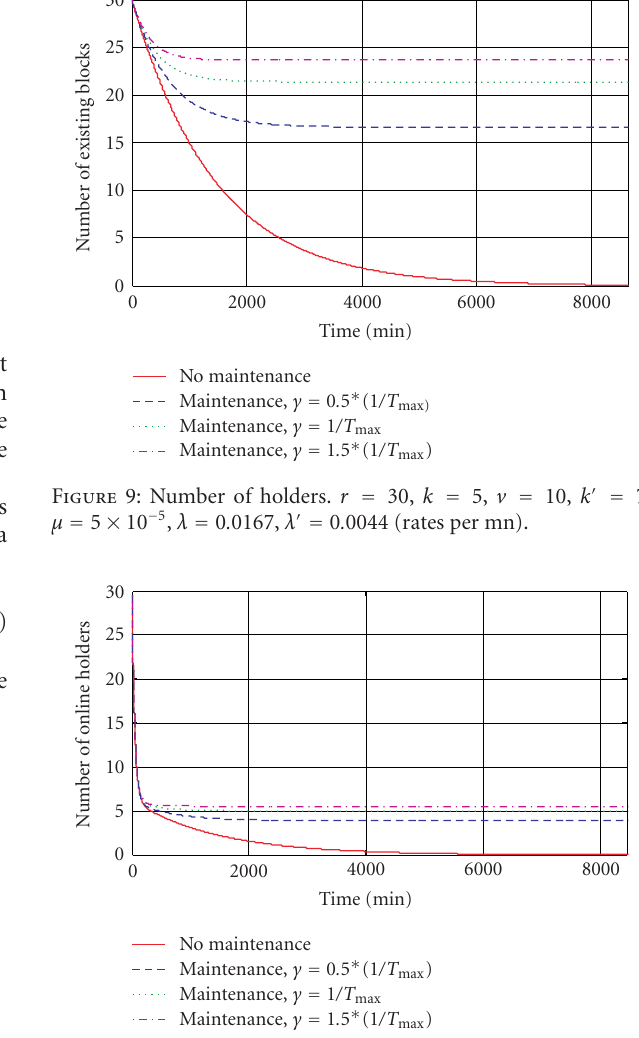
Figure 10: Number of online holders. r = 30, k = 5, v = 10 , k (cid:2) = 7, μ = 5 × 10 − 5 , λ = 0 . 0167, λ (cid:2) = 0 . 0044 (rates per